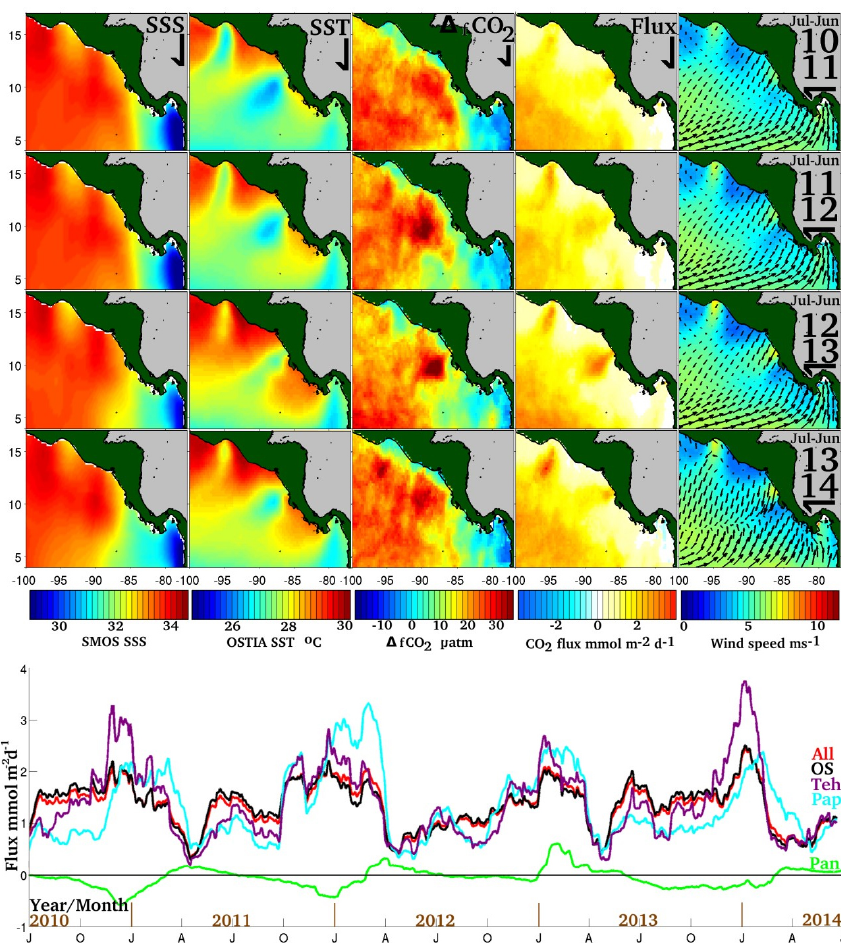
Figure 8. Upper image: yearly average SSS, SST LUT-derived (cid:49)f CO 2 , air–sea fluxes and wind vectors for the ETPO for July to June 2010 + 2011, 2011 + 2012, 2012 + 2013 and 2013 + 2014. Lower image: the continuous LUT-derived f CO 2 fluxes from the entire ETPO (red line), the gulfs of Tehuantepec (purple), Papagayo (blue), Panama (green) and the South Equatorial Current